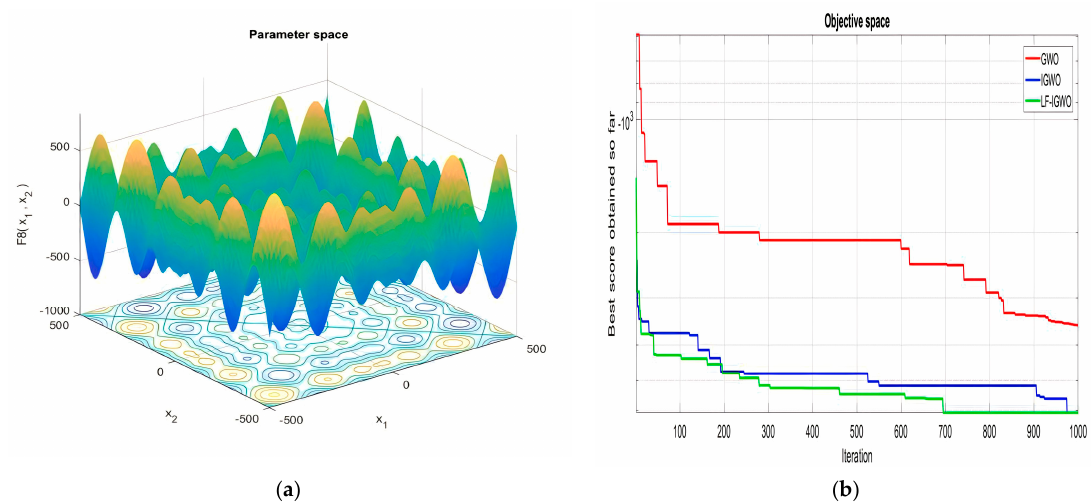
Figure 10. ( a ) Search space for multi model function F08 ( b ) Comparison of convergence curve for F08.